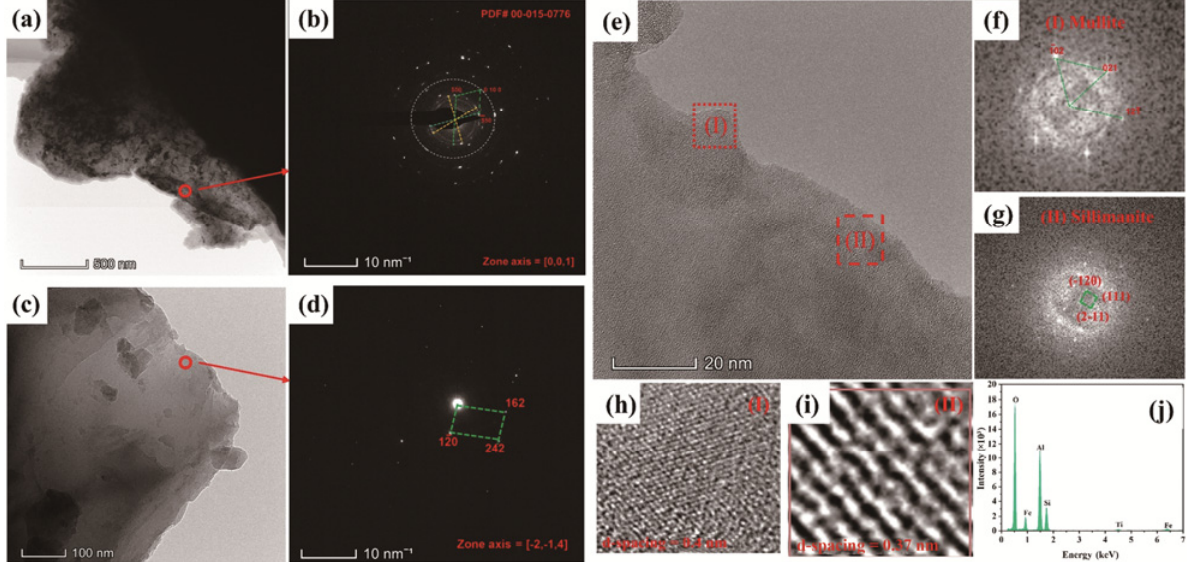
Fig. 10 TEM analyses of the sample S4 sintered at 1400 ℃ : (a–d) TEM images and SAED patterns of circled area, (e) high- resolution TEM image, (f, g) FFT analyses of areas (I) and (II) in (e), respectively, (h, i) enlarged images of areas (I) and (II) in (e), respectively, and (j) EDS spectra for individual